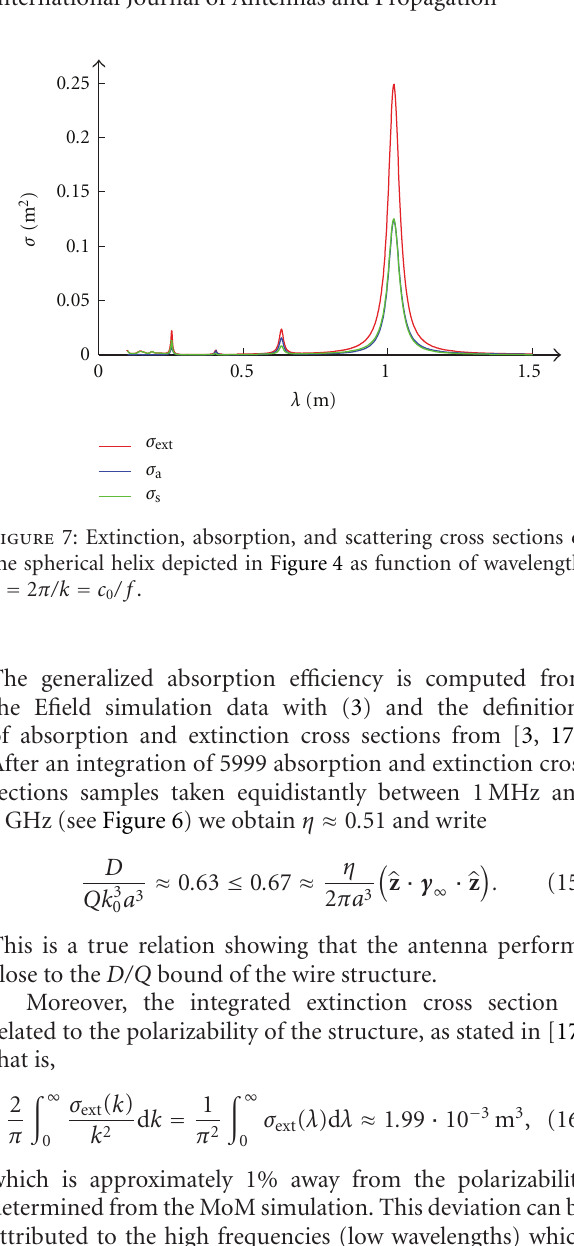
The generalized absorption e ffi ciency is computed from